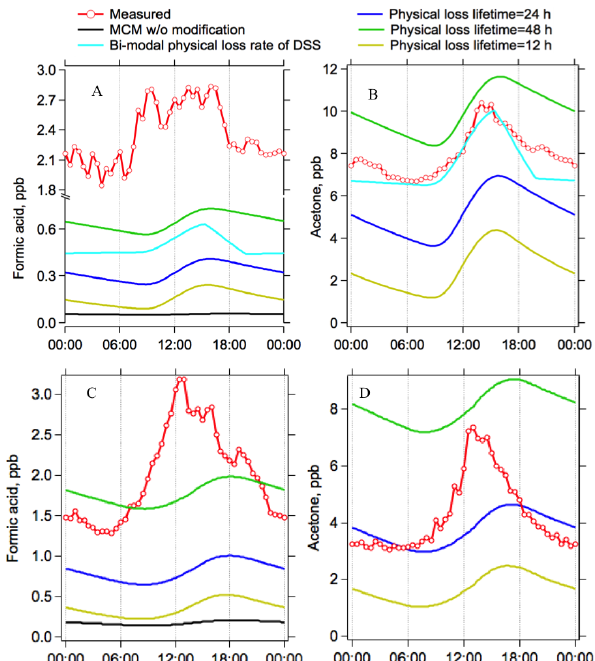
Figure 5. Comparison of measured and modeled diurnal profiles of formic acid and acetone for UBWOS 2013 (a, b) and CalNex (c, d) using different lifetimes due to physical